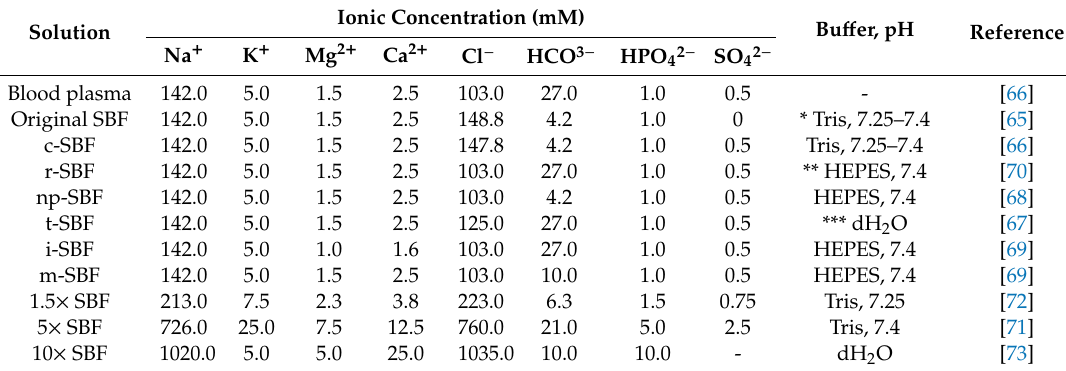
Table 1. Composition of simulated body fluid (SBF) and its